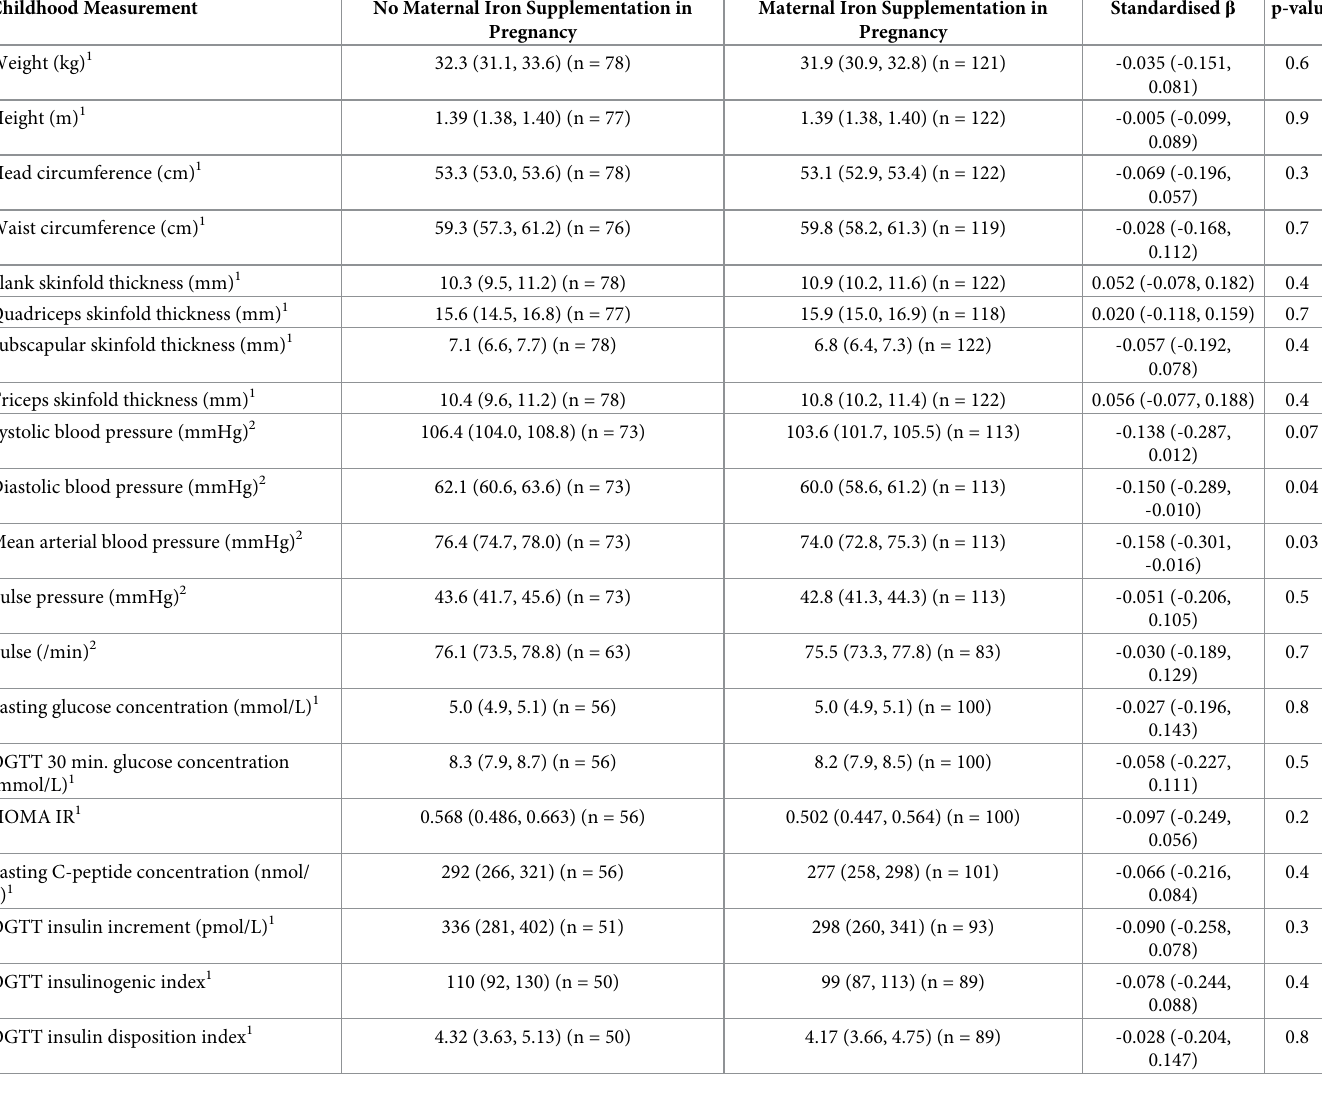
Table 2. Associations between maternal iron supplementation status in pregnancy and offspring growth and physiological measurements at around age 9.5